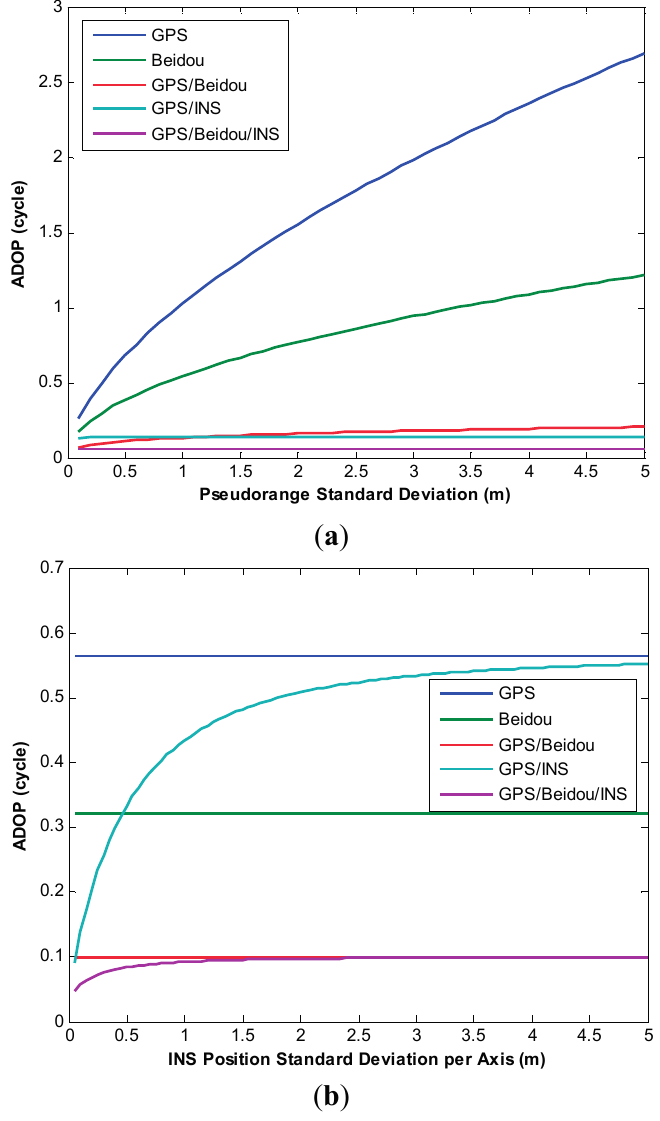
Figure 8. ( a ) Effect of pseudorange accuracy on ADOP; ( b ) Effect of INS position accuracy on